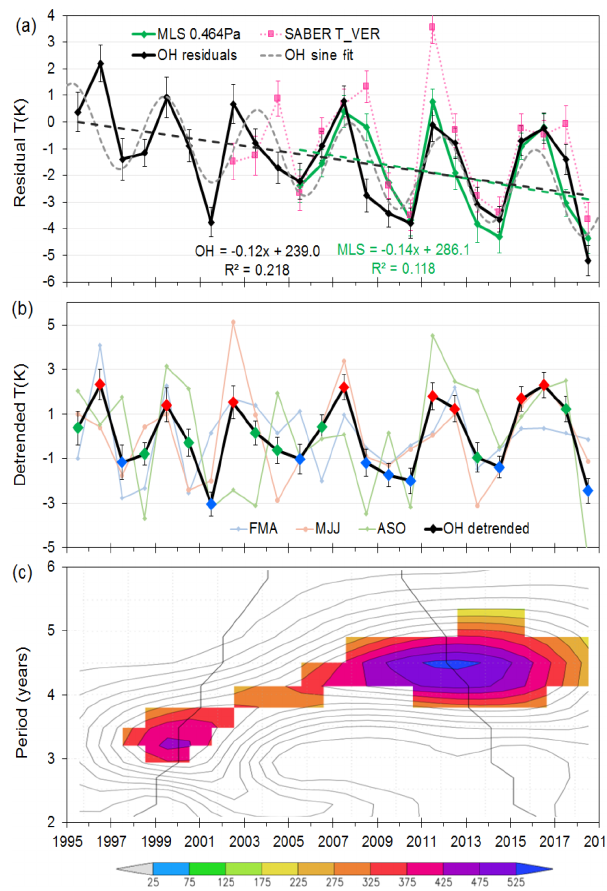
Figure 1. (a) Davis OH winter mean residual (solar response re- moved) temperatures (black line, standard error in mean error bars, dashed linear fit) compared with Aura/MLS (AMJJAS) mean resid- ual temperatures for 0.0046hPa (green line, standard error-in-mean error bars, dashed linear fit) and TIMED/SABER (pink dotted line, standard error-in-mean error bars). Grey dotted line is a sinusoid fit (peak–peak amplitude 3 . 0 ± 0 . 1K period 4 . 2 ± 0 . 7 years) provided as a guide. (b) Detrended Davis OH winter mean temperatures (AMJ- JAS) (black line, long-term linear fit removed) compared to FMA, MJJ, and ASO monthly averages (red, green, and blue points mark warm, mid, and cold years respectively for composite studies). (c) A Morlet wavelet transform (order 6) of the detrended Davis OH win- ter mean temperatures. Coloured sections are power above 90% sig- nificance level. The black line indicates the cone of influence; points outside have been influenced by the boundaries of the time